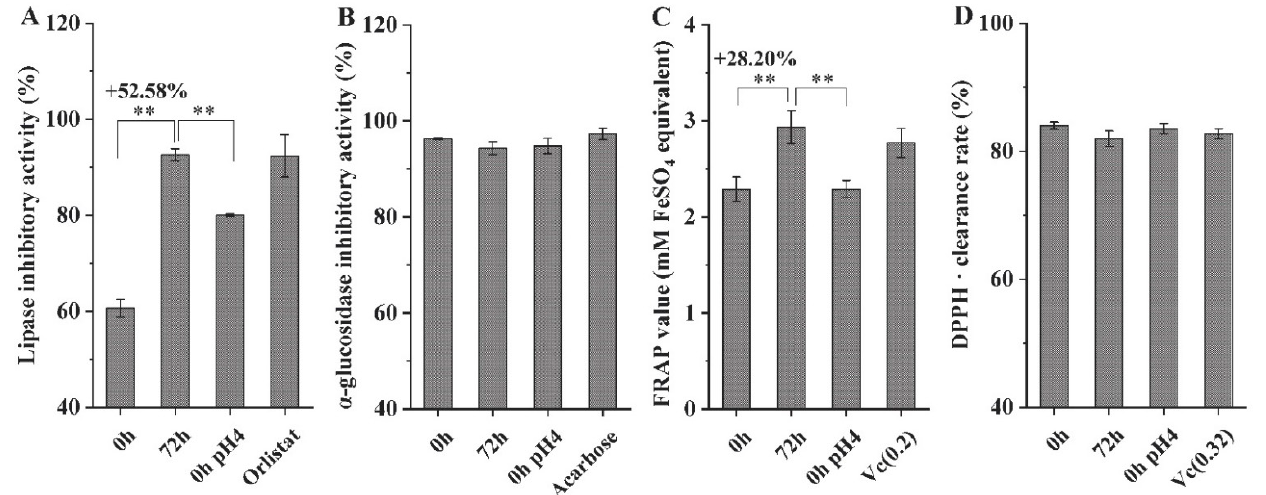
Figure 5. Effects of L. fermentum grx08 fermentation on the functional characteristics of SHLE at 0 h and 72 h. ( A ) Inhibition of lipase activity; ( B ) inhibition of α -glucosidase activity; ( C ) total antioxidant capacity (FRAP); ( D ) DPPH · scavenging rate. Data are expressed as the mean ± standard deviation (SEM). ** p < 0.01 indicates that there was a significant difference between 0 h and 72 h. FRAP, ferric reducing-antioxidant power. “0 h pH 4” means lactic acid was used to adjust the extraction solution for fermentation for 0 h to the pH value of 4. Positive controls: Orlistat, 0.5 mg/mL. Acarbose, 0.001 mg/mL. Vc(0.2), 0.2 mg/mL vitamin C. Vc(0.32), 0.32 mg/mL vitamin